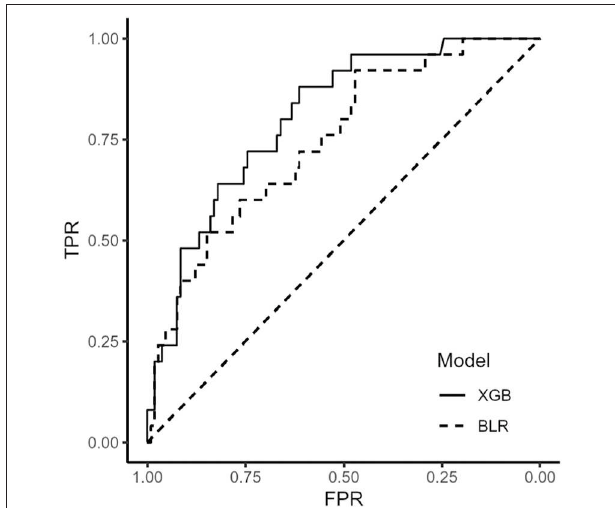
FIGURE 3 | Receiver operating characteristic curve of binary logistic regression and extreme gradient boosting algorithm. BLR, binary logistic regression; XGB, extreme gradient